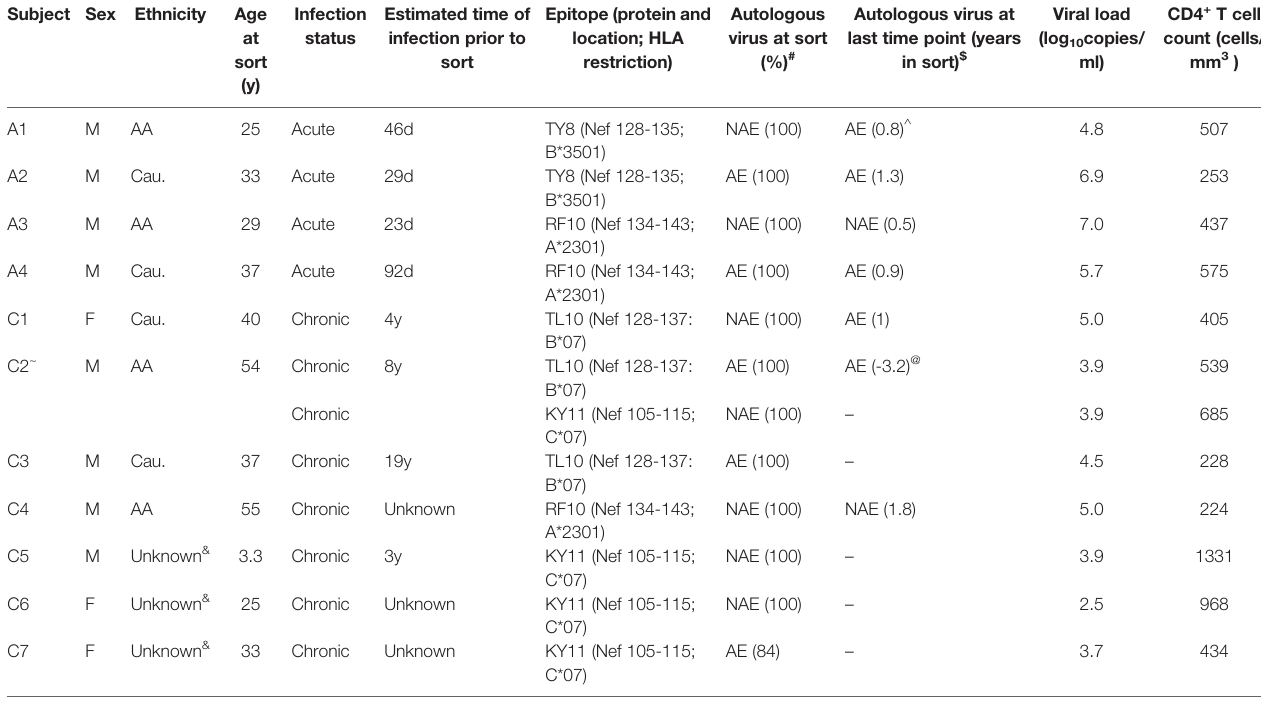
TABLE 1 | Clinical, demographic and virological data of study subjects *